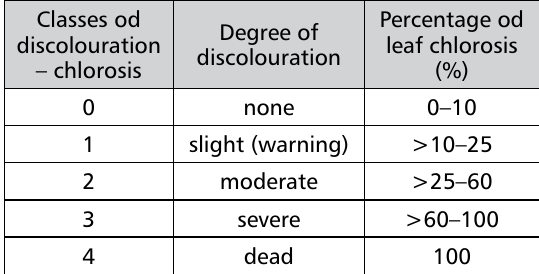
Classes of discolouration according to ICP